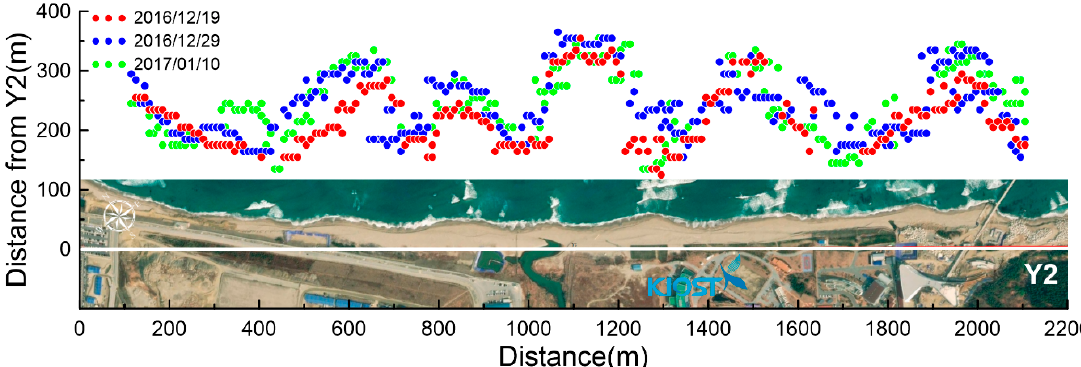
Figure 10. Comparison of crescentic sandbar crest positions between the Sentinel-II images on 11 December 2016 ( red dots ), 31 December 2016 ( blue dots ) and 30 January 2017 ( green dots ) extracted using the algorithm by [21]. It shows that, in most parts of the sandbars, the crests moved offshore for maximum 70 m for 20 days between 11 December 2016 and 31 December 2016. Since then, the bar positions became stable without showing severe cross-shore movement until 30 January 2017. The data were not estimated at the profiles where the peak was not detected by the algorithm.